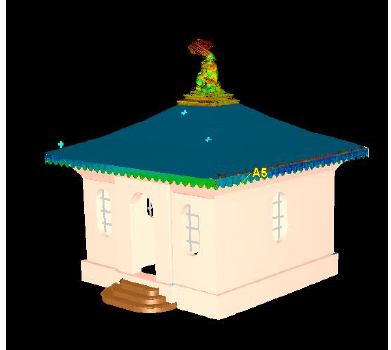
Figure 3: 3D Model by TLS